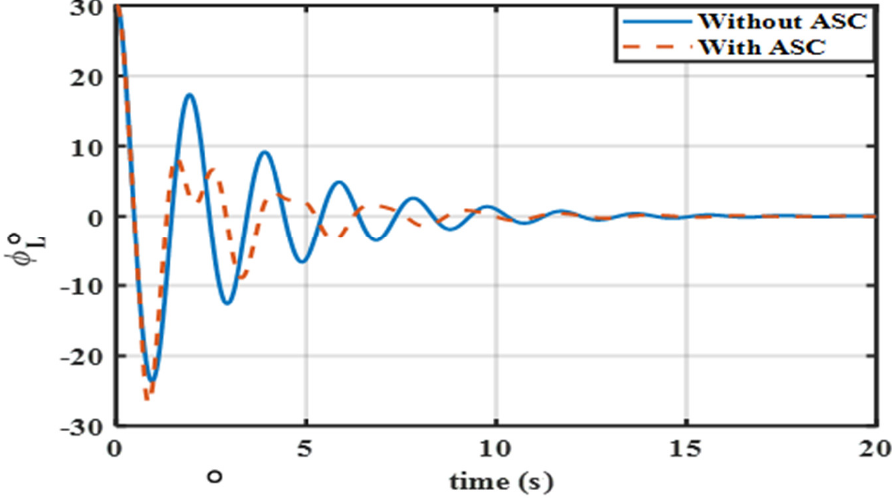
Figure 25. Time history of the in-plane load swing angle during hover using numerical simulations.